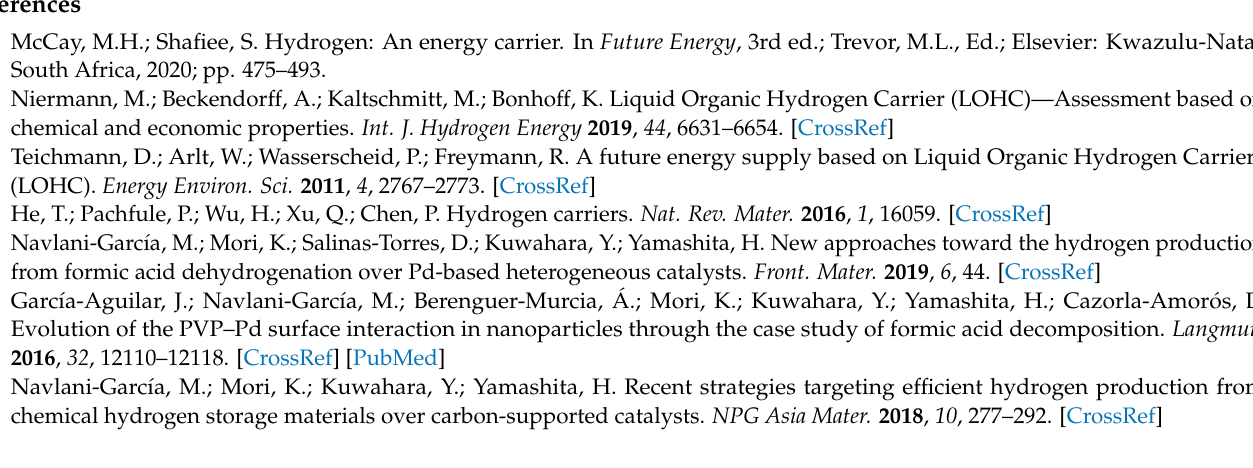
(a) Pd/BC, (b) Pd/N-BC, (c) Pd/BC_TT, and (d) Pd/N-BC_TT, Figure S2. TEM micrographs for Pd/BC catalyst fresh and used after 6 cycles, Figure S3. TEM micrographs for Pd/N-BC catalyst fresh and used after 6 cycles, Figure S4. TEM micrographs for Pd/BC_TT catalyst fresh and used after 6 cycles, Figure S5. TEM micrographs for Pd/N-BC_TT catalyst fresh and used after 6 cycles, Figure S6. XPS N1s spectra of the BC and